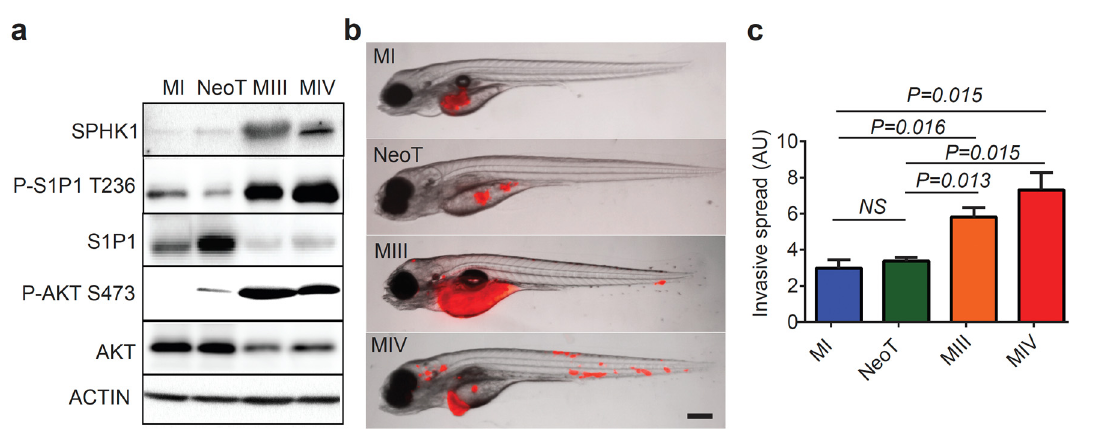
Figure 2. Increased Levels of P-S1P1 T236 are linked with TNBC Progression. ( a ) Western blot analysis of SPHK1, P-S1P1 T236, S1P1, phospho-AKT S473 (P-AKT S473), AKT, and ACTIN levels in human MI, NeoT, MIII, and MIV cells. ( b ) Overlay of brightfield and fluorescence images of zebrafish embryos transplanted with RFP + human MI, NeoT, MIII, and MIV cells at 3 days post-transplantation (dpt; n = 3 per group). The scale bar represents 200 µm. ( c ) Quantification of invasive spread in zebrafish embryos based on fluorescence intensity of MI, NeoT, MIII, and MIV cells ( n = 3 per group). Data presented as Mean ± SEM. NS, not signi fi cant.